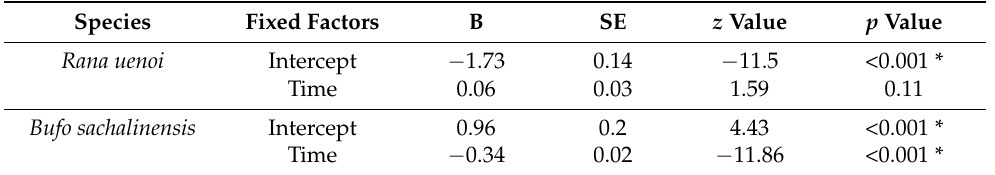
Table 3. Results of the binomial logistic regression assessing the relation between the movement (swim vs. immobile) of tadpoles and time course for Rana uenoi ( n = 268) and Bufo sachalinensis ( n = 240). B = beta coefficient; SE = standard error; significant results are labeled with “*”.